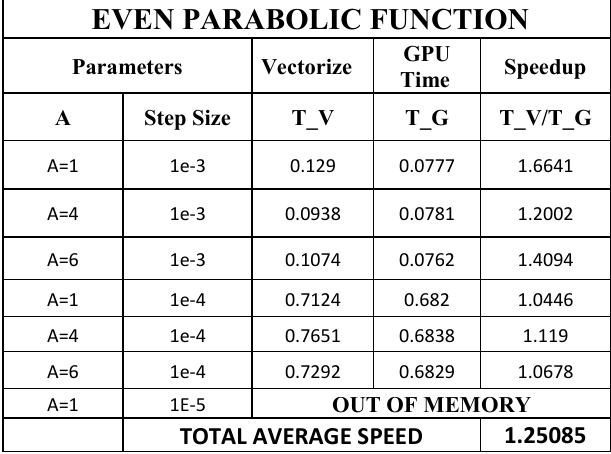
Table 4. : Speedup Time for Even Parabolic Function